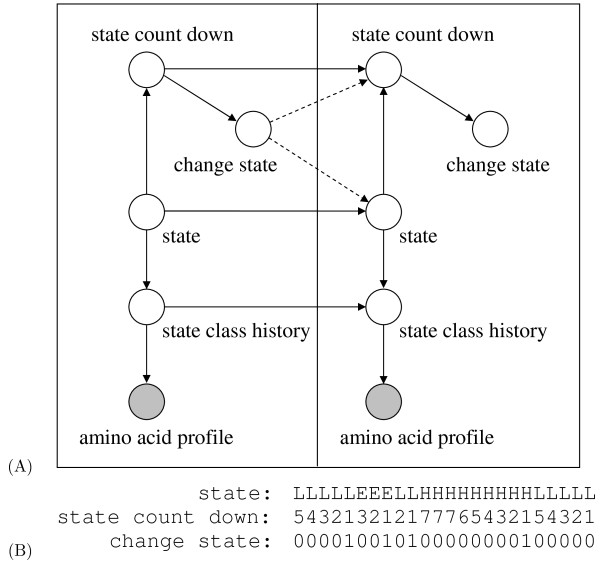
A dynamic Bayesian network for protein secondary structure prediction. (A) The first column shows the variables of the prologue (models the first amino acid) and the second column shows the variables of the chunk (models the second up to the last amino acid). The chunk is rolled (i.e.) extended to the right to get the final network. (B) An example state sequence and the values of state count down and change state variables for Dmax = 7. state count down and change state are used to control transitions from one secondary structure segment to the next and model the length distribution of segments.